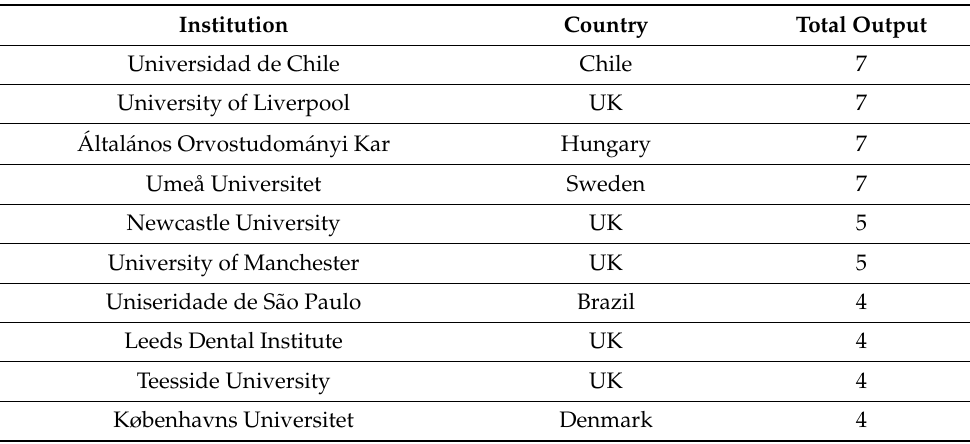
Table 4. Top ten institutions having highest number of original research articles on milk